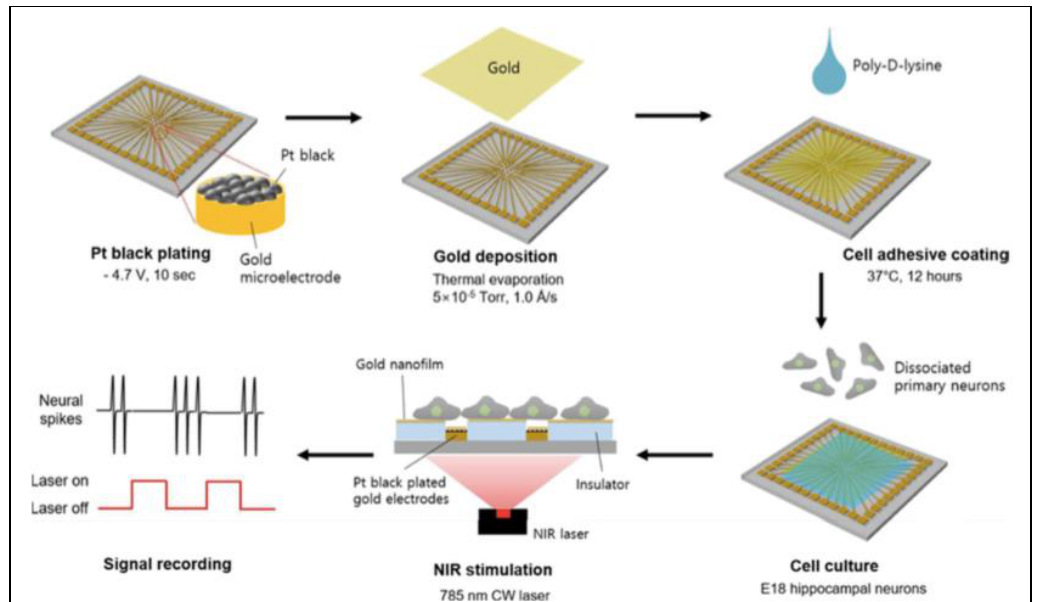
Nanomaterials 2019 , 9 , x FOR PEER REVIEW Figure 14. Illustration of the general procedures used to investigate the interactions between neural networks and PNF surfaces. Reproduced with permission from [19]. Royal Society of Chemistry, 2018.